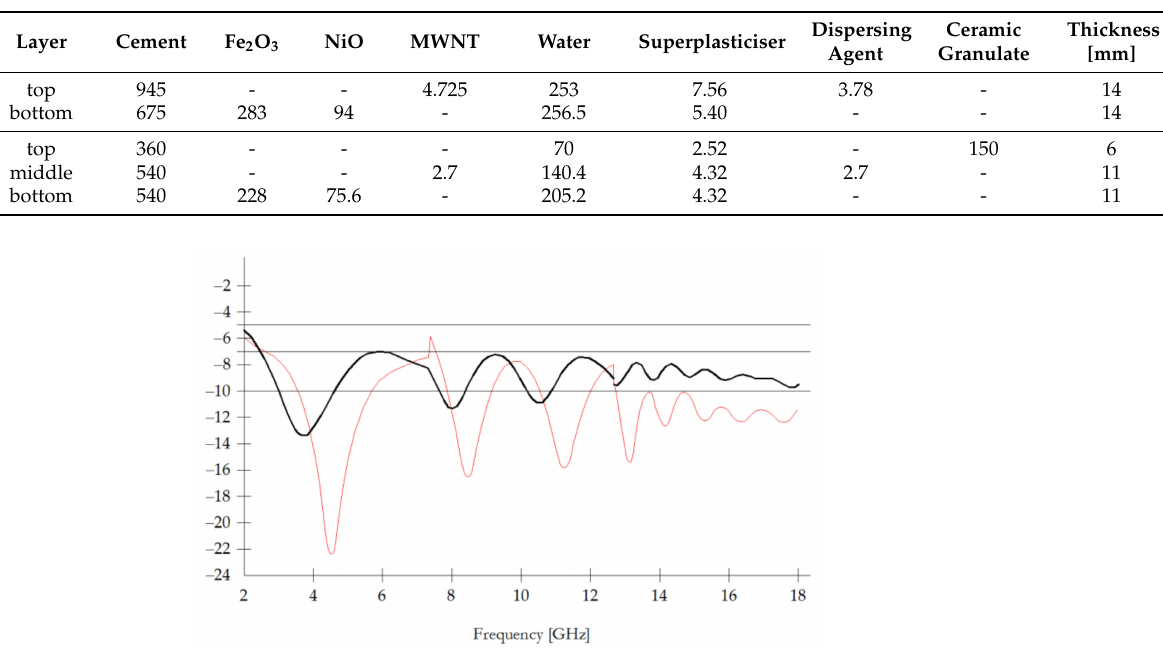
Table 2. Composition (in grams) of sandwich composite panels (after [60]).